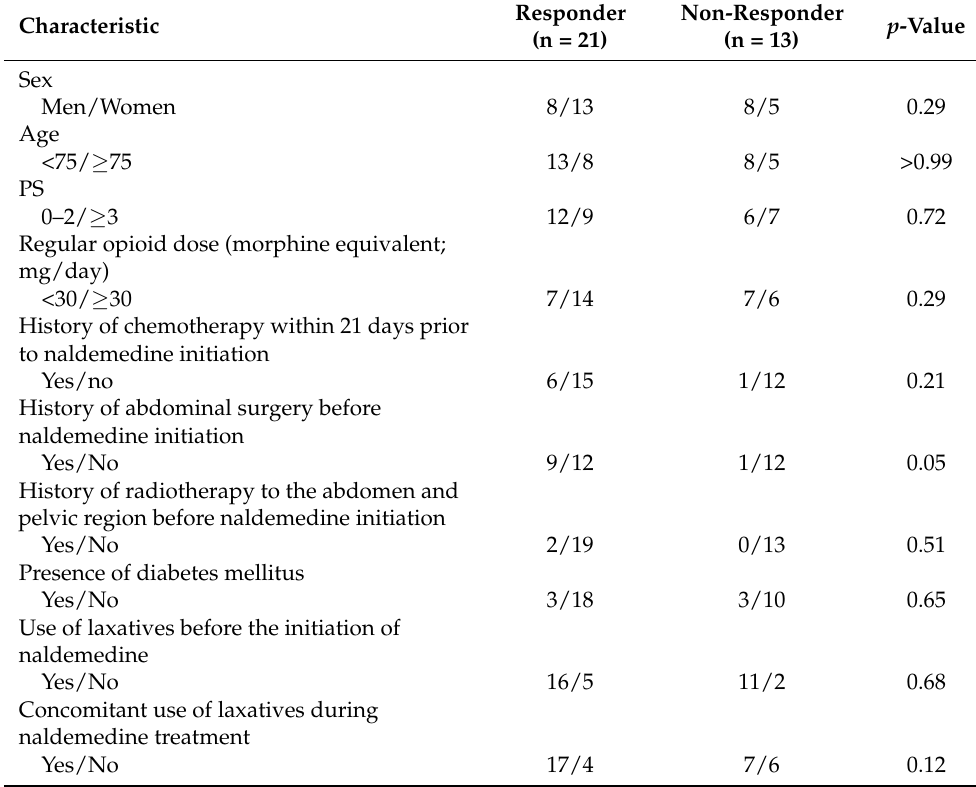
Table 3. Patient backgrounds based on